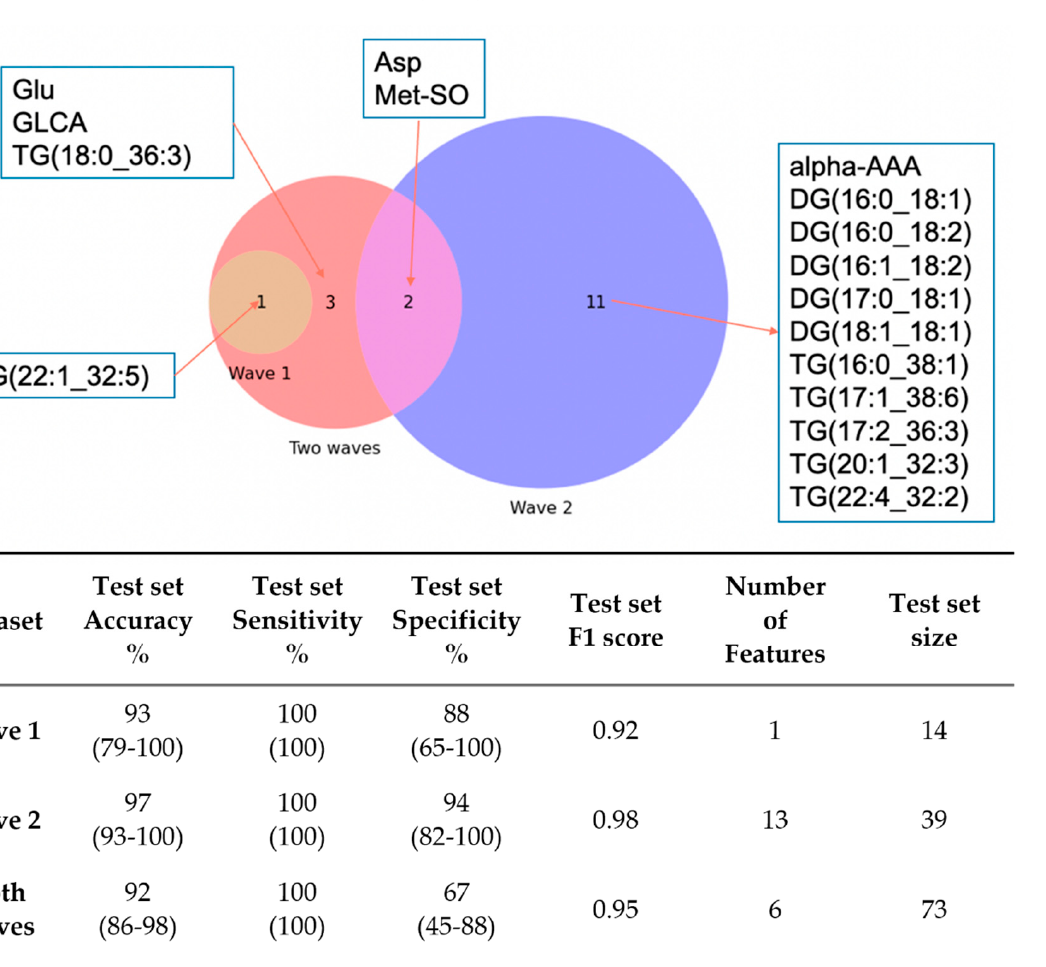
Figure 3. ( A ) Venn diagram for the features identified by machine learning to be predictive for COVID-19 diagnosis in Wave 1, Wave 2 and across waves (where DG: diglycerides and TG: triglyc- erides); and ( B ) Machine learning model prediction results in test set of Wave 1, Wave 2 and across waves, the 95% confidence intervals are enclosed in the parentheses.